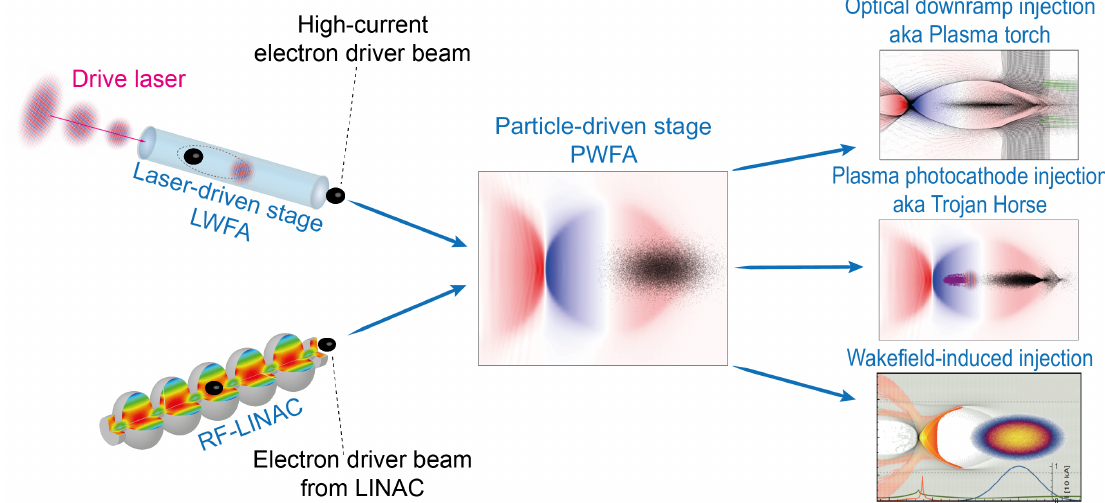
Figure 8. Schematic overview on: linac-driven PWFA ( top left ); hybrid LWFA+PWFA ( bottom left ); and three different PWFA injection schemes ( right